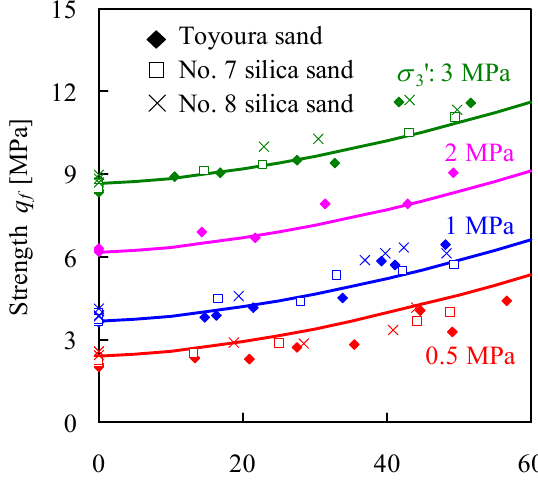
Figure 7. Strength q from the reference